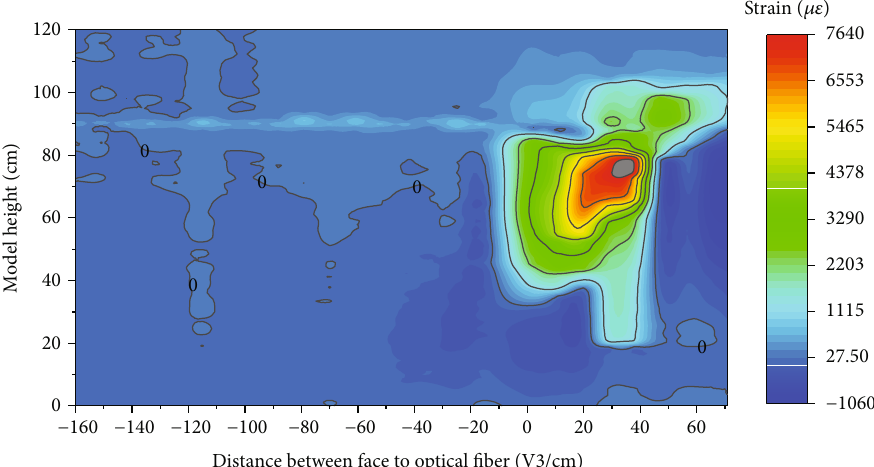
Figure 5: Strain distribution of fi ber V3 during the mining of coal seam 1 -2 (the abscissa is the model height, and the ordinate is the distance between the face and the optical fi